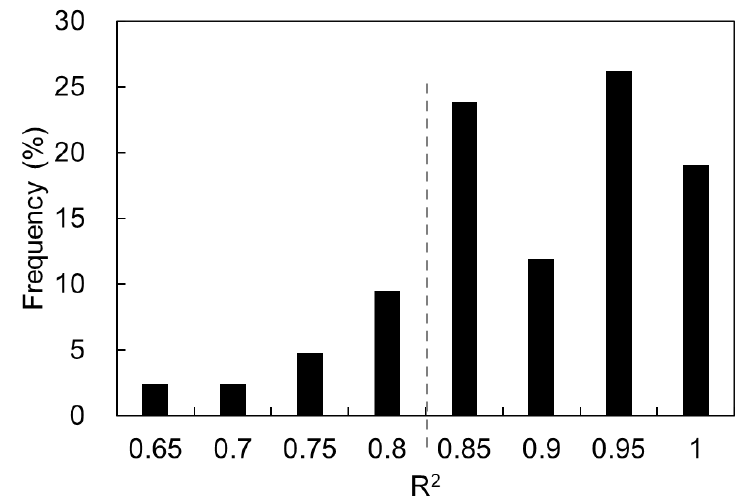
Figure 6. Distribution of R 2 values for Equation (6).